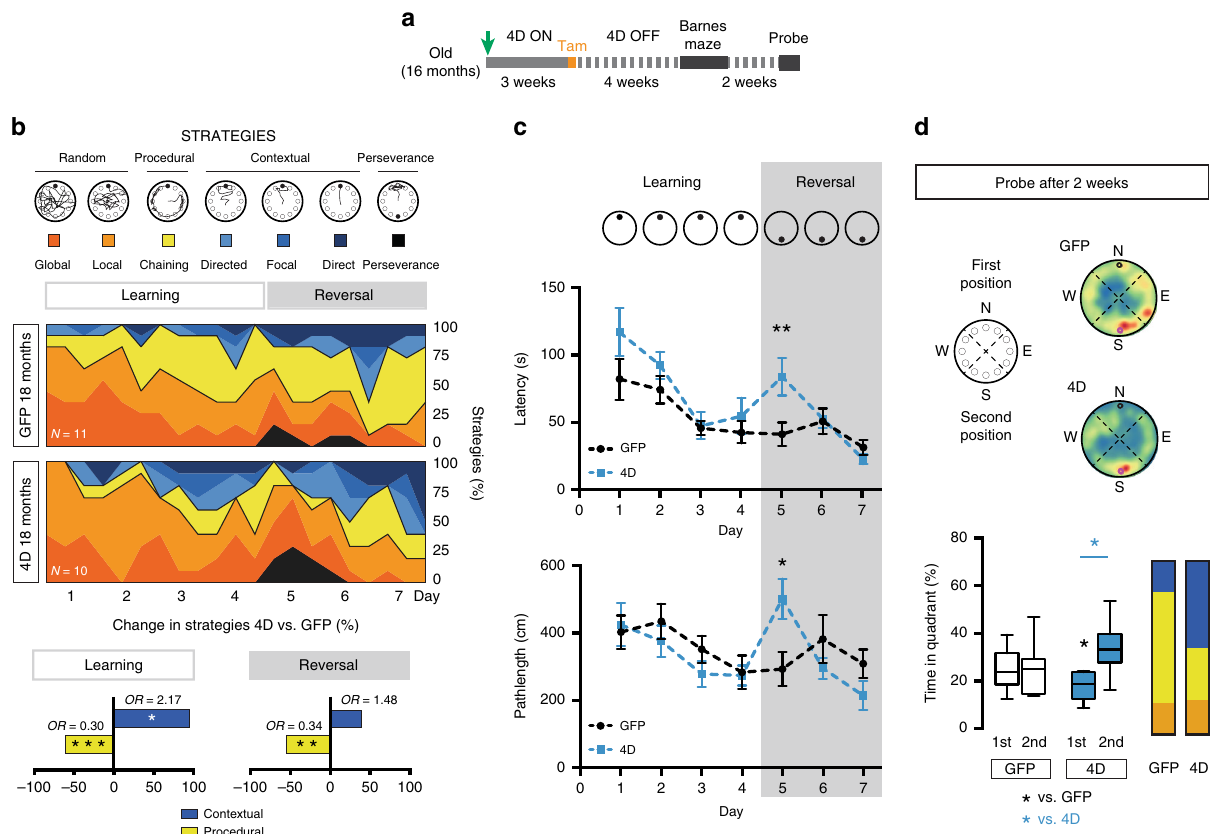
Fig. 3 An acute increase in neurogenesis rejuvenates navigational strategies and spatial memory. a Experimental layout to assess the effects of acute increase in neurogenesis on navigational strategies in old mice. b Drawings exemplifying colour-coded searching tracks (top) and their mean relative contribution during 7 days of testing of GFP or 4D mice (as indicated) including learning and reversal phases (middle). Changes and odds ratios (OR) in contextual (blue) vs. procedural (yellow) strategies of 4D-treated relative to control, old mice are depicted by grouping together all trials of the two phases (bottom). c Latency (s; top) and pathlength (cm; bottom) of 4D-treated (blue) and control (black) mice performing the test shown in b . Note the increase in both parameters in 4D mice only the fi rst day after reversal (day 5). d Schematic representation, heatmaps (top) and box – whisker plots quanti fi cations (bottom) displaying quadrant preference of mice 2 weeks after the testing shown in b . Note the increased preference of 4D mice for the 2nd position of the escape box relative to both the 1st position (paired t test, blue * p = 0.010) and control mice (unpaired t test, black * p = 0.030) and the increased use of contextual vs. procedural navigation (colour coded as in b ; bar graph, right). N = 11 and 10 (as indicated); values represent means of each day depicted as percentage ( b and d ) or numerical units ( c ). Bars in c SEM. * p < 0.05; ** p < 0.01; *** p < 0.001 assessed by Wald-test ( b ) and paired or unpaired Student ’ s t test (for intra or inter-group comparisons, respectively; c and d